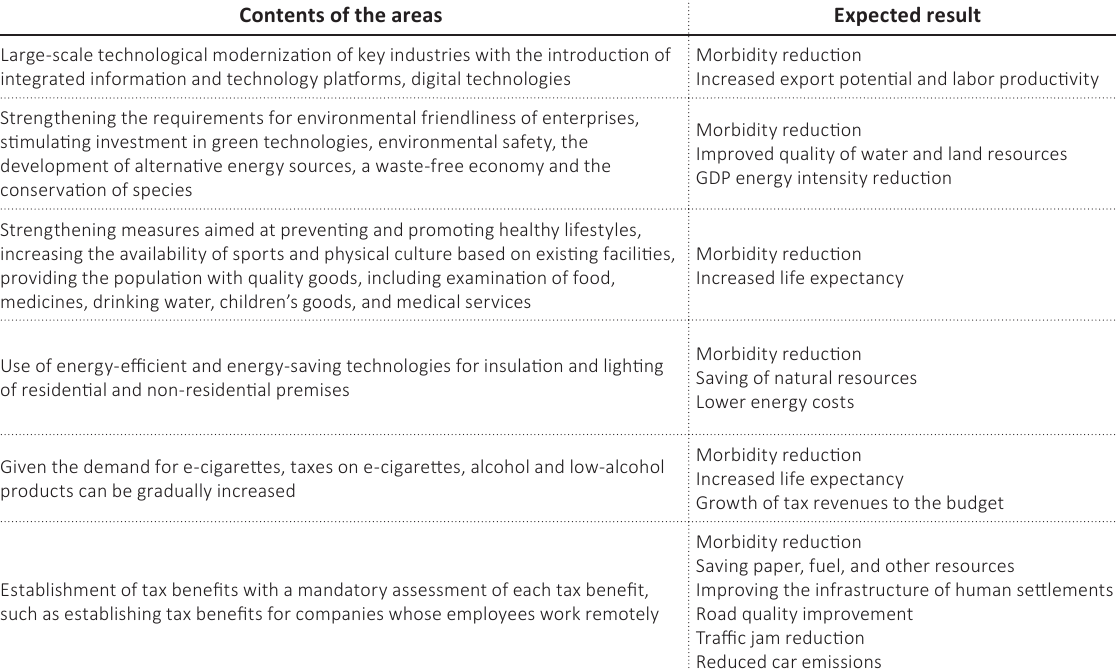
Table 1. The list of alternative areas of budget financing and expected results of the efficient use of budget